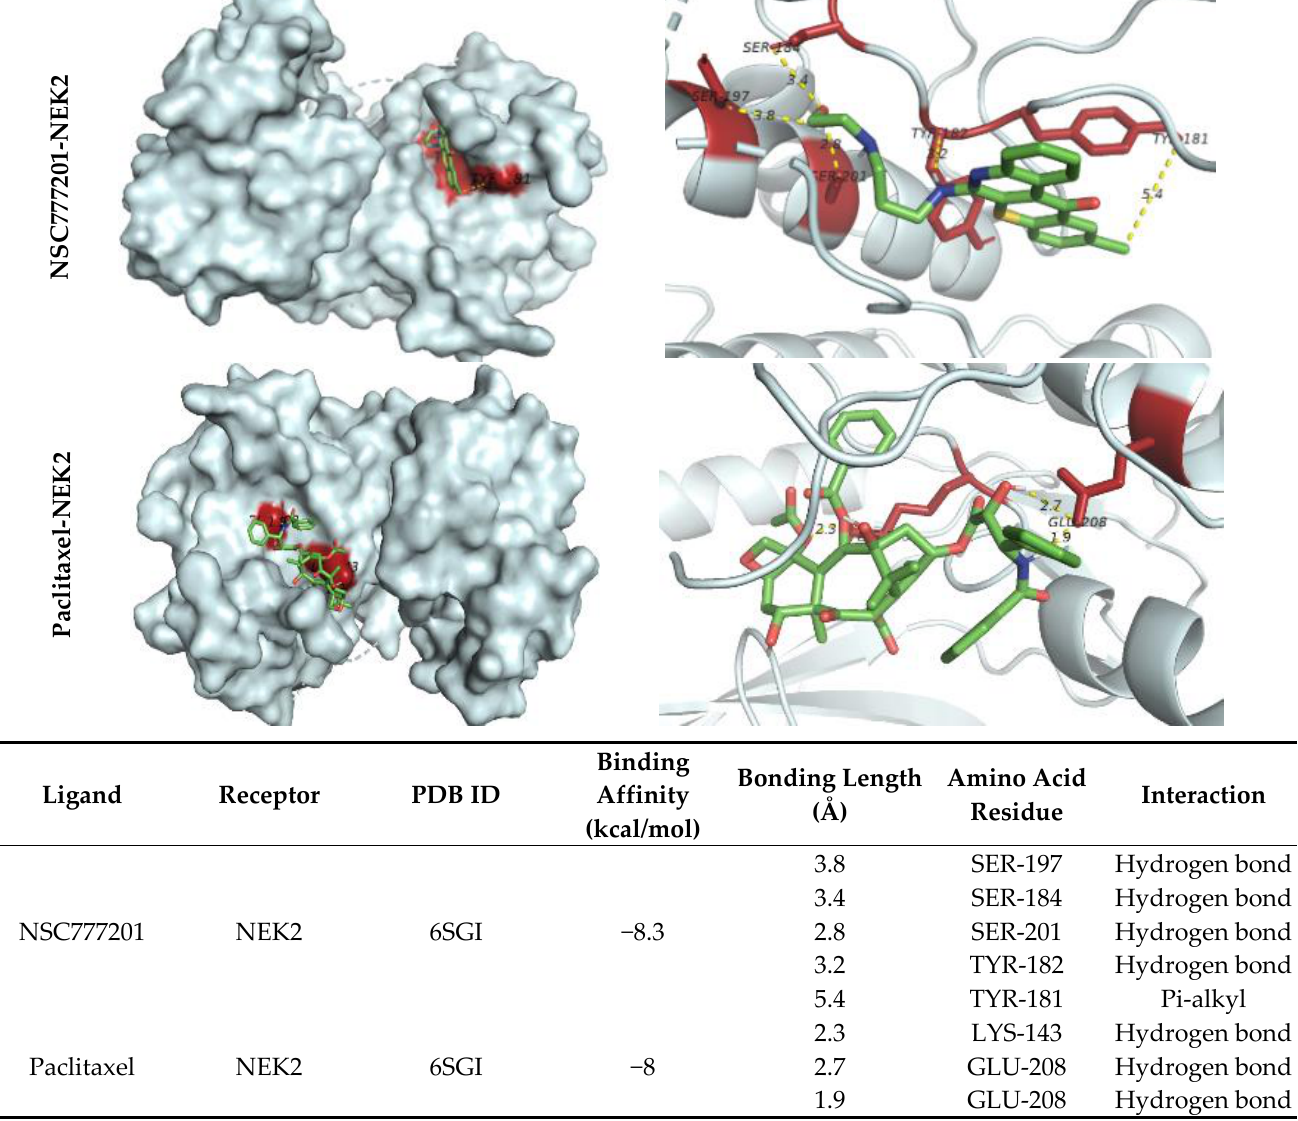
Table represents the ligand receptor-interacting atoms, binding affinities, and interacting distances of NSC777201 and NEK2. Figure 8. Docking profile of NEK2 with NSC777201 and paclitaxel (a known inhibitor). 3D structure of ligand-receptor interactions shown in the left panel. The right panel shows the 2D representation of the interaction with ligands and the receptors in the binding pocket.